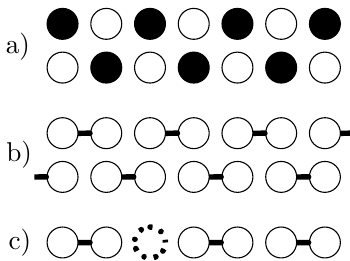
Figure 9 . A cartoon picture of zero correlation length representatives of the two symmetry broken phases. a) represents the two charge density waves that occur for large g 2 dots represent filled/empty sites. b) represents the two different ground states with bond order for large g 2 ( σ 6 = 0 ). The connected dots represent the dimerized states ( | 10 i + | 01 i ) / x occupation basis. c) represents a kink in the σ condensate. Imposing inversion symmetry around the central site automatically breaks all possible inversion symmetries around bonds, which ensures that any such defect nucleates a non-zero value of the π order